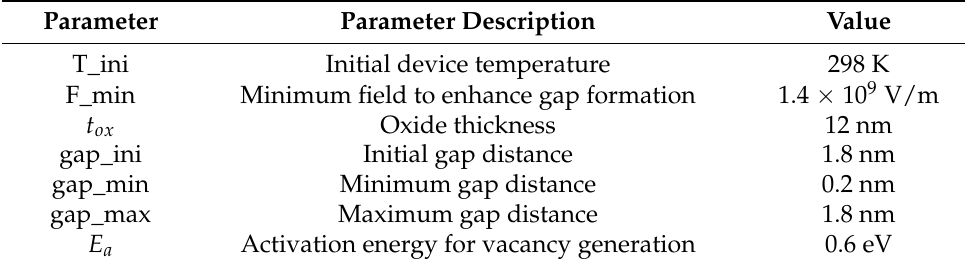
Table 6. Characteristic parameters of RRAM